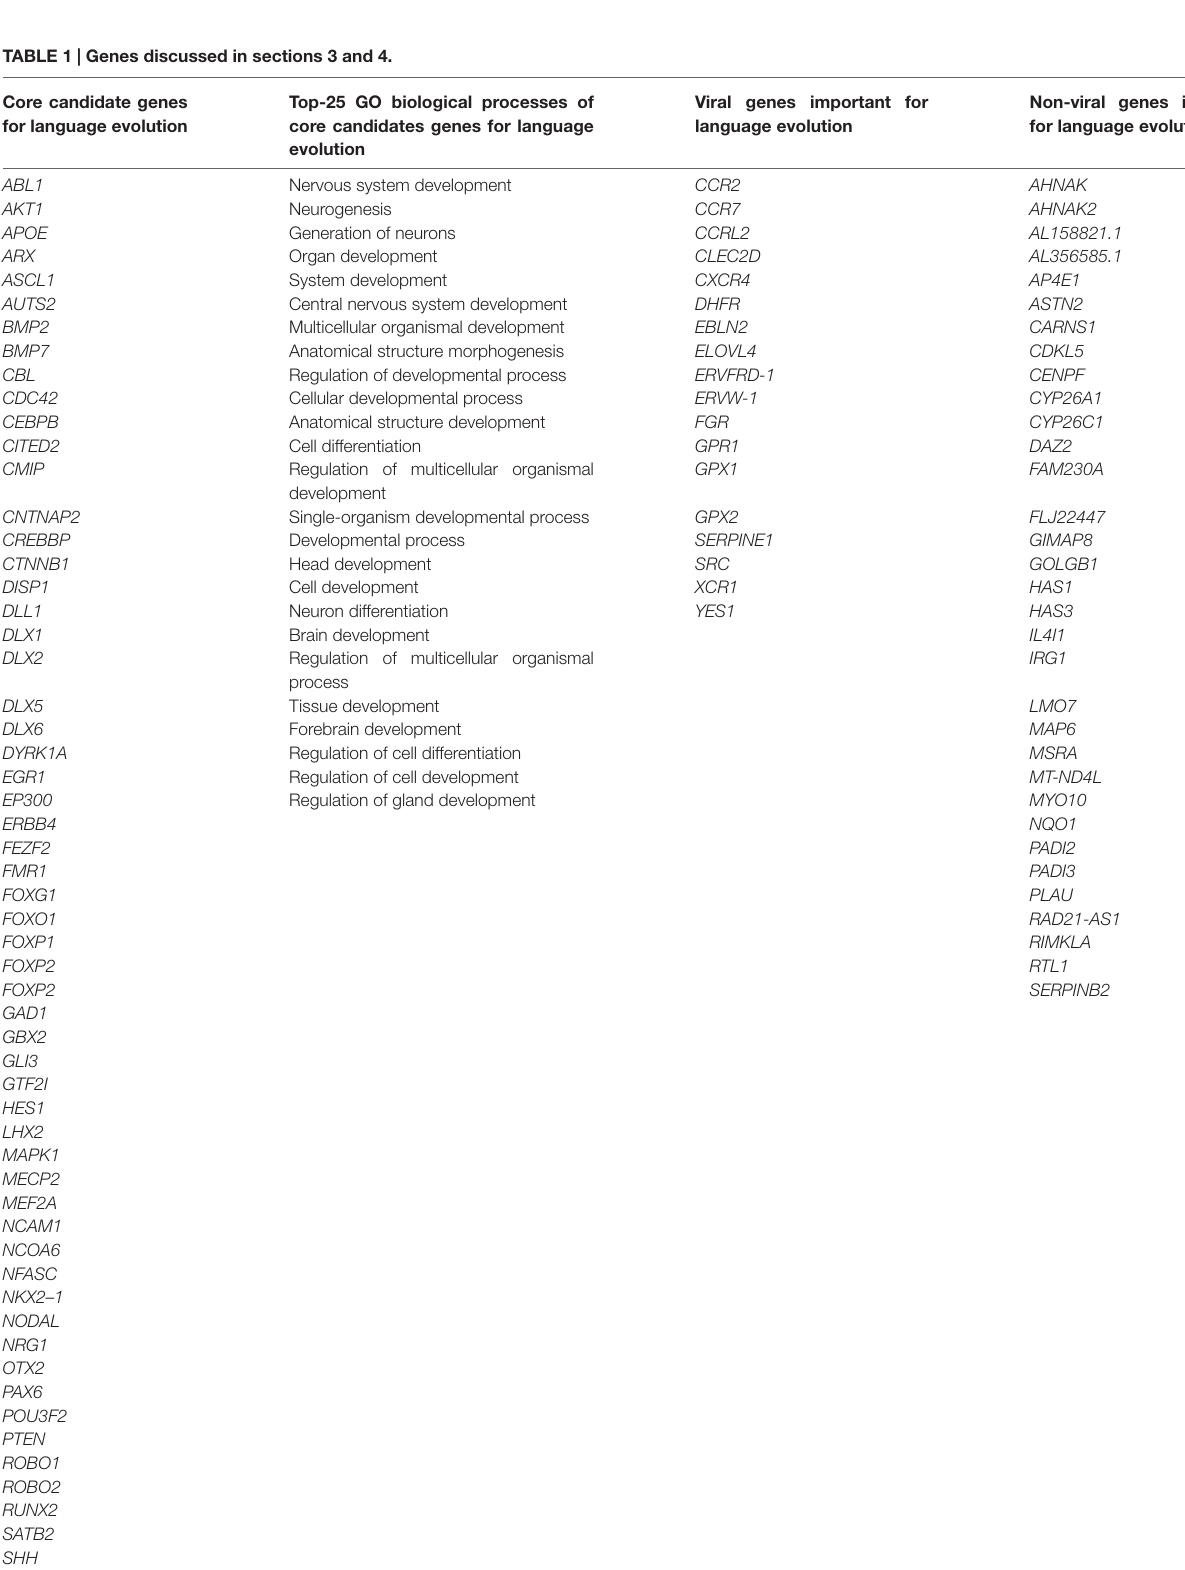
TABLE 1 | Genes discussed in sections 3 and 4. Core candidate genes for language